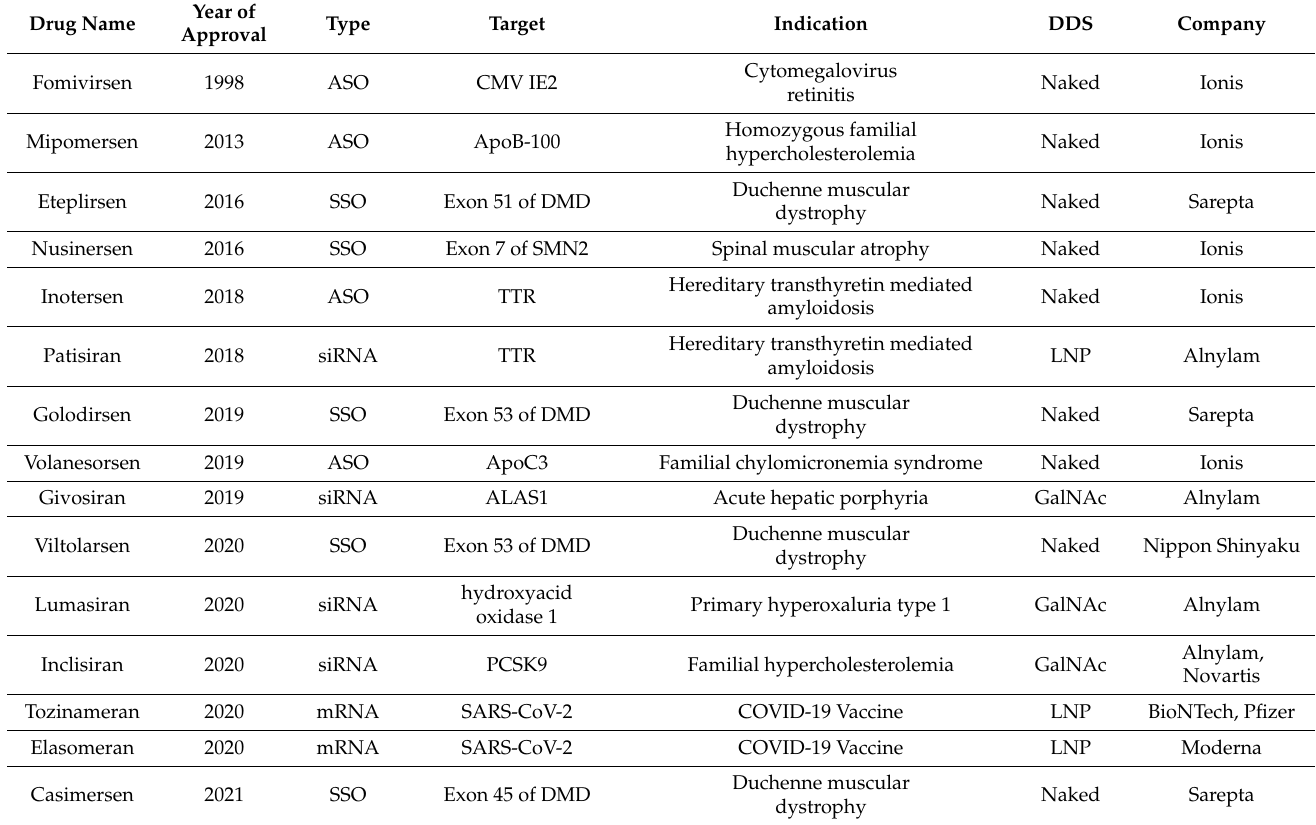
Table 2. Nucleic acid drugs approved by the FDA or EMA (as of 30 June 2021).